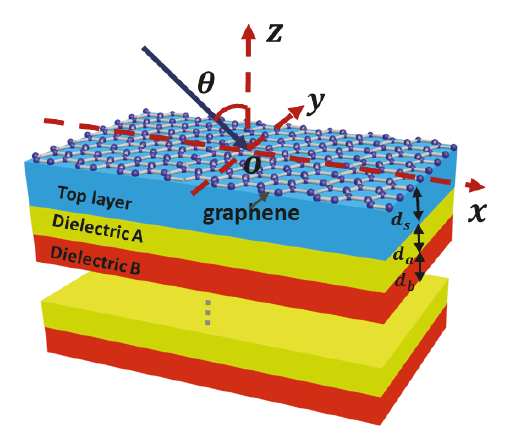
Figure 1: Schematic diagram of a graphene-1D PC composite structure. The incident angel is 𝜃 . The period of photonic crystal is m = 20